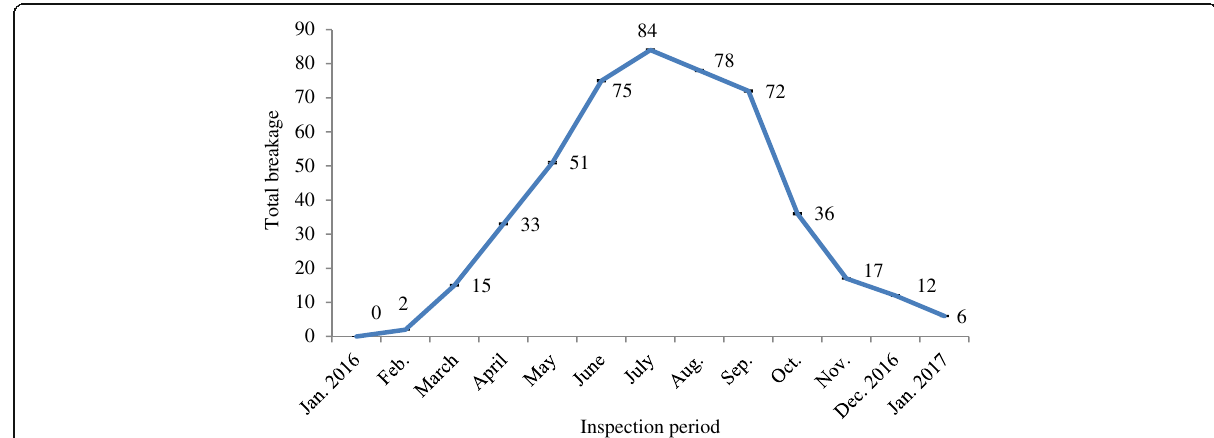
Fig. 3 Total monthly frond breakage/15 trees at Siwa date palm groves (from January 2016 to January 2017)